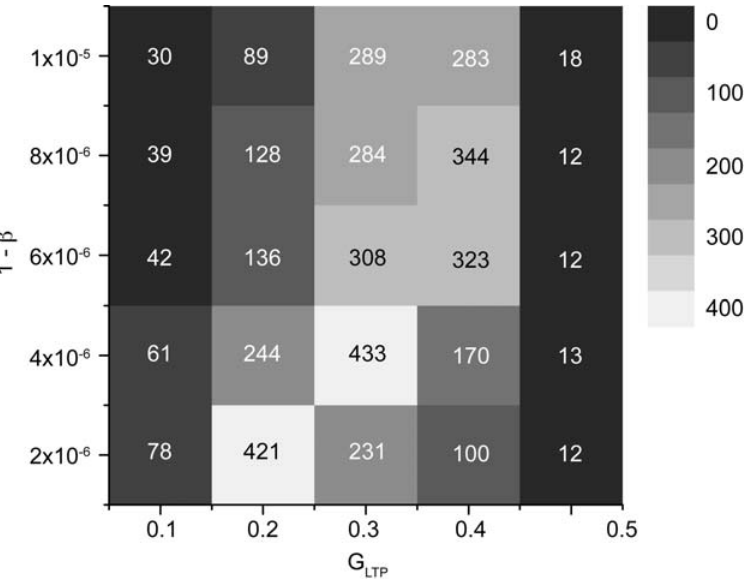
Figure 8. The network size as a function of the parameters G LTP and b . Each square represents a single simulation with the pair of simulation parameters indicated on the axes. For each point, the simulation was run until there were no further changes in the supersynaptic structure. Next, the simulation was run for an additional 100 trials, spike data was collected, and the number of neurons that spike in at least 75 percent of all trials was counted; this number, called the network size, is coded by grayscale and written in each box. A higher value indicates a longer synfire chain network since more neurons are induced to spike regularly.